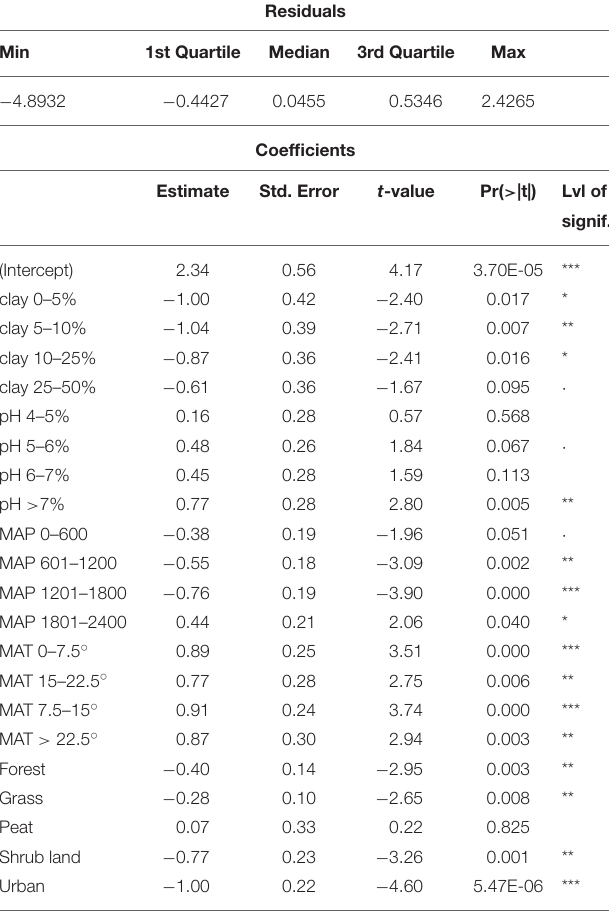
TABLE 3 | Summary of the model statistics used for the global